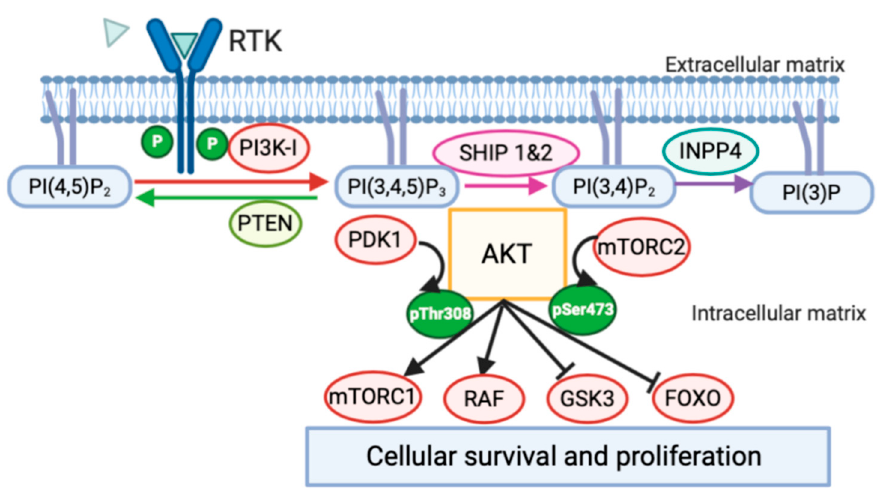
Figure 1. Modification of PtdIns Mediated by PI3K, PTEN, SHIP, INPP4 and the PI3K signaling pathway in cancer: The phosphorylated state of inositol lipids inserted in the cell membrane is controlled by inositol kinase and phosphatase enzymes. As proposed in “The Two PIP hypothesis” [22], the presence of both PI(3,4,5)P 3 and PI(3,4)P 2 at the membrane triggers downstream signaling events that more effectively promote cancer cell survival. Downstream targets of AKT are both pro-survival (activation of mTORC1, RAF) and anti-apoptotic (inhibition of GSK-3, FOXO) permitting increased cancer cell survival and proliferation.